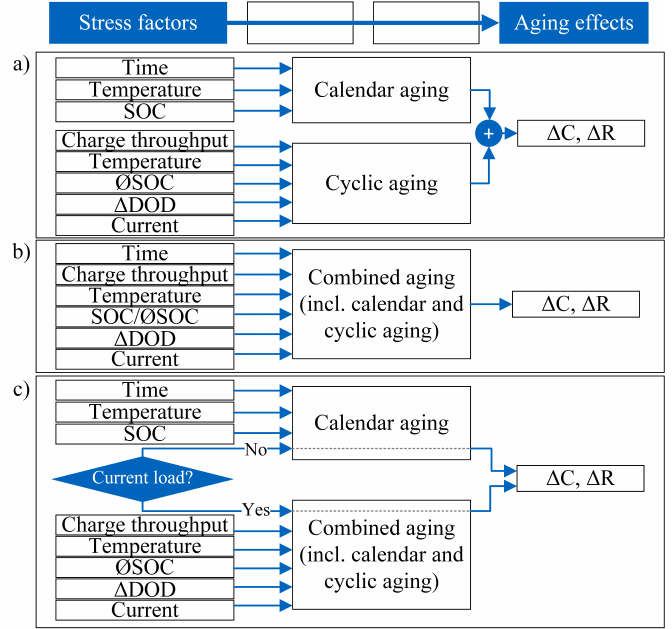
Figure 2. Overview of modeling approaches with different concepts to consider calendar and cyclic aging: ( a ) superposition approach, ( b ) combined approach, and ( c ) case distinction